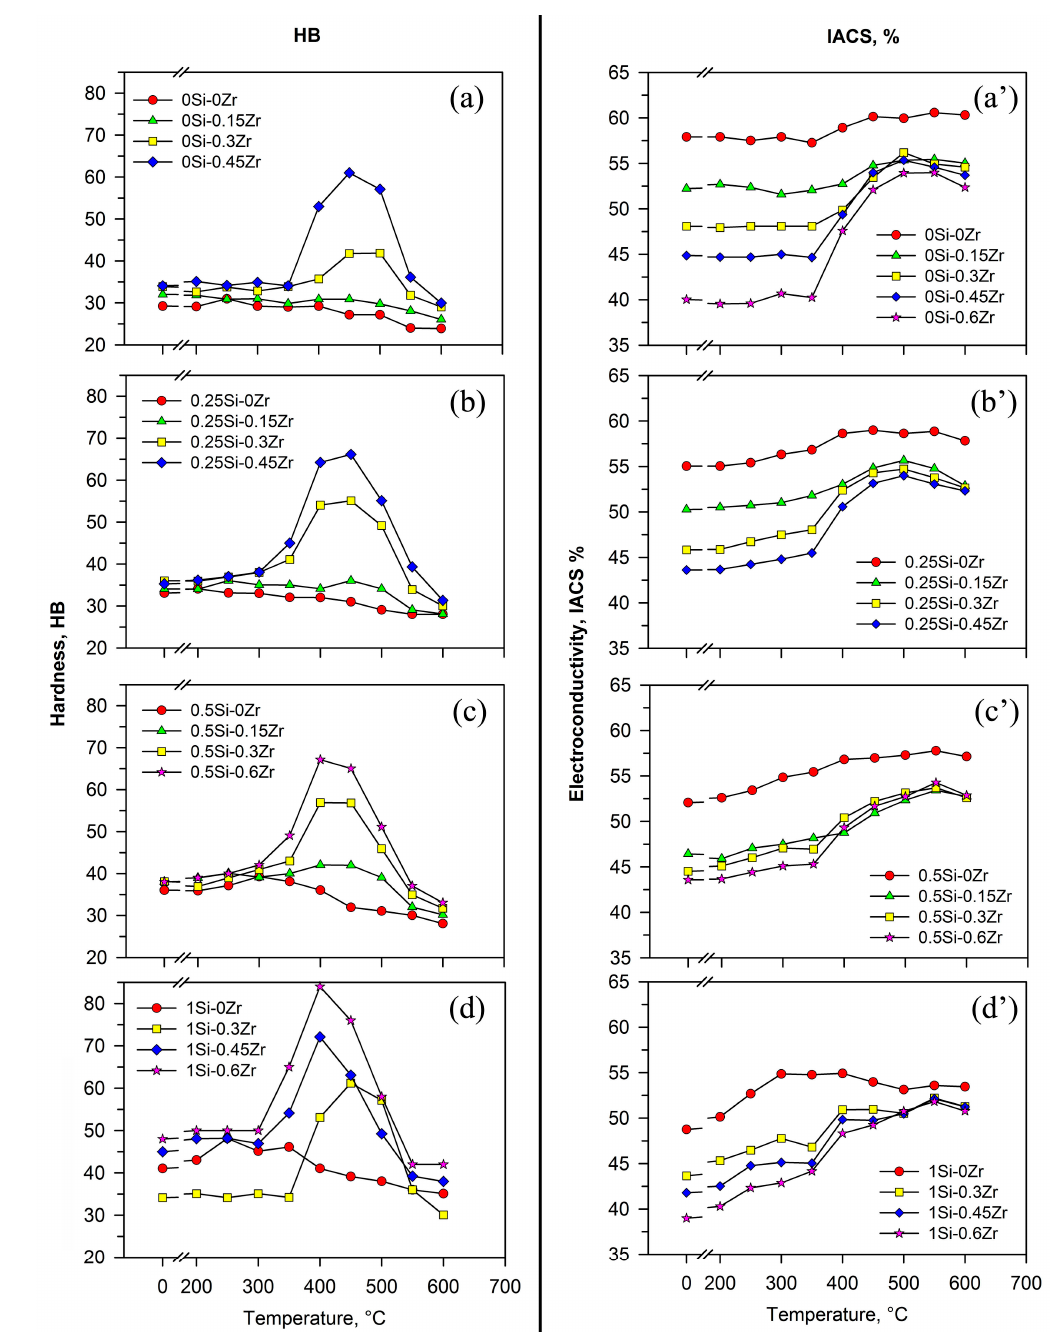
Figure 7. Temperature dependence of the microhardness ( a – d ) and the electrical conductivity ( a – d’ ) for Al-1% Fe-Si-Zr alloys with a fixed content of Si and different contents of Zr: ( a, a’ ) 0 wt. % Si; ( b, b’ ) 0.25 wt. % Si; ( c, c’ ) 0.5 wt. % Si; ( d, d’ ) 1.0 wt. % Si.